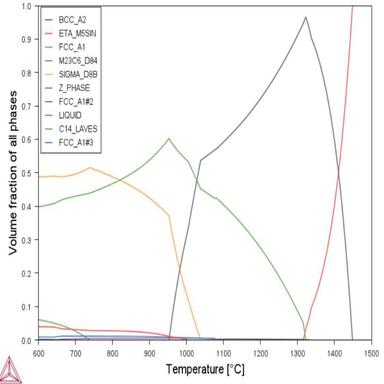
Phase Diagram of SDSS-Nb, amount of phases vs temperature, calculated by Thermo-Calc.